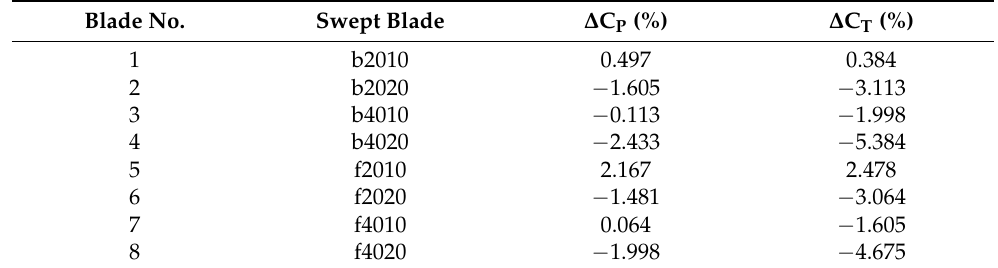
Table 3. Changes in power coefficients and thrust coefficients of the wind turbine with swept blades. Blade No.